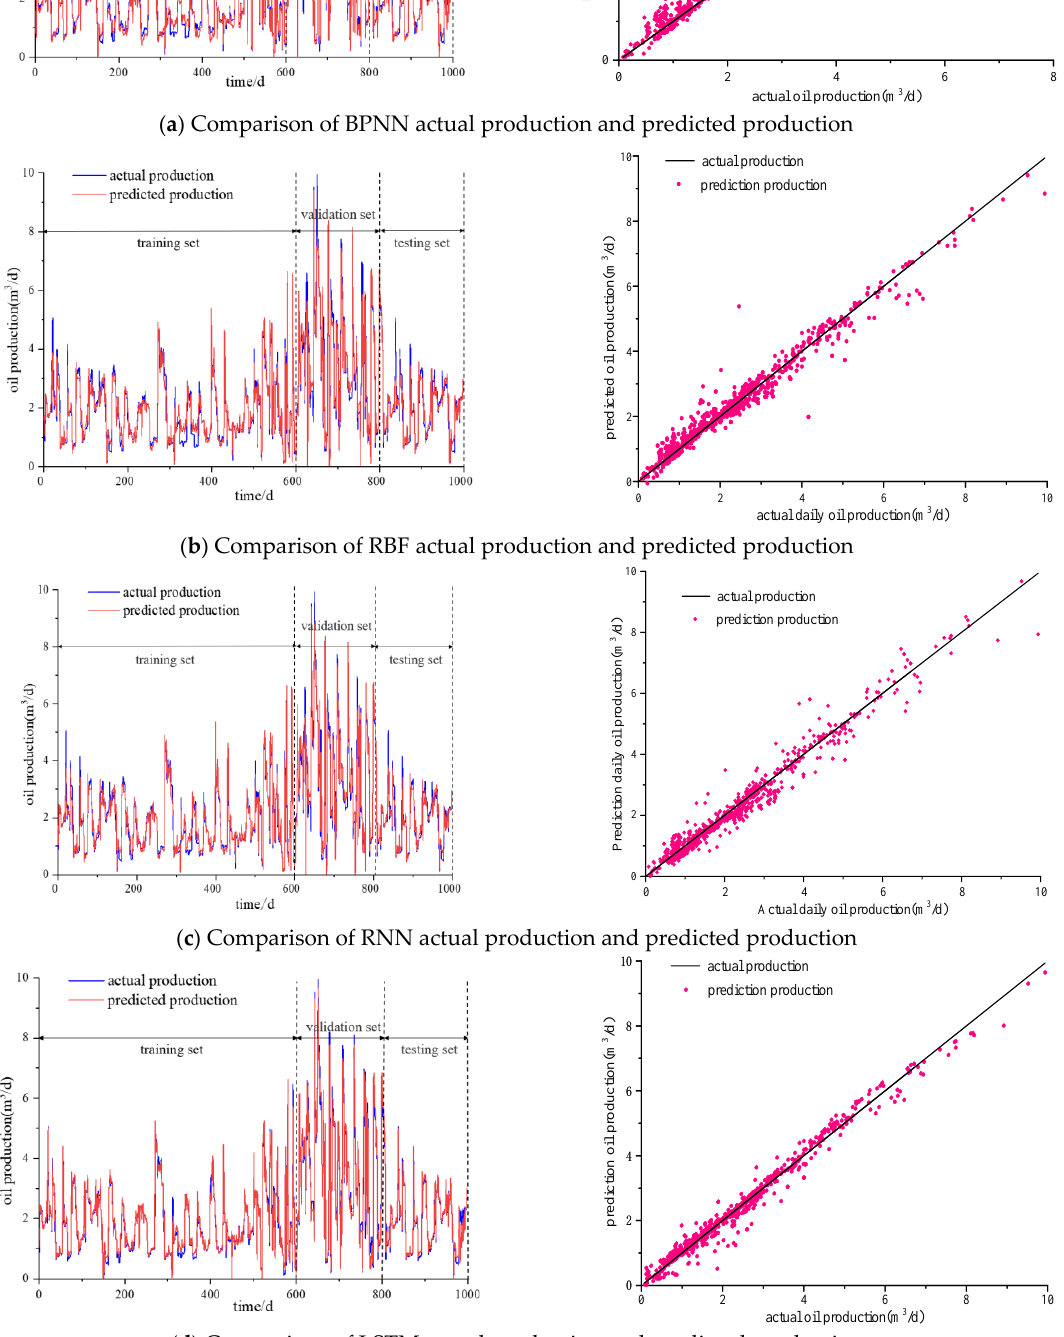
Figure 8. Prediction results of four neural network models.